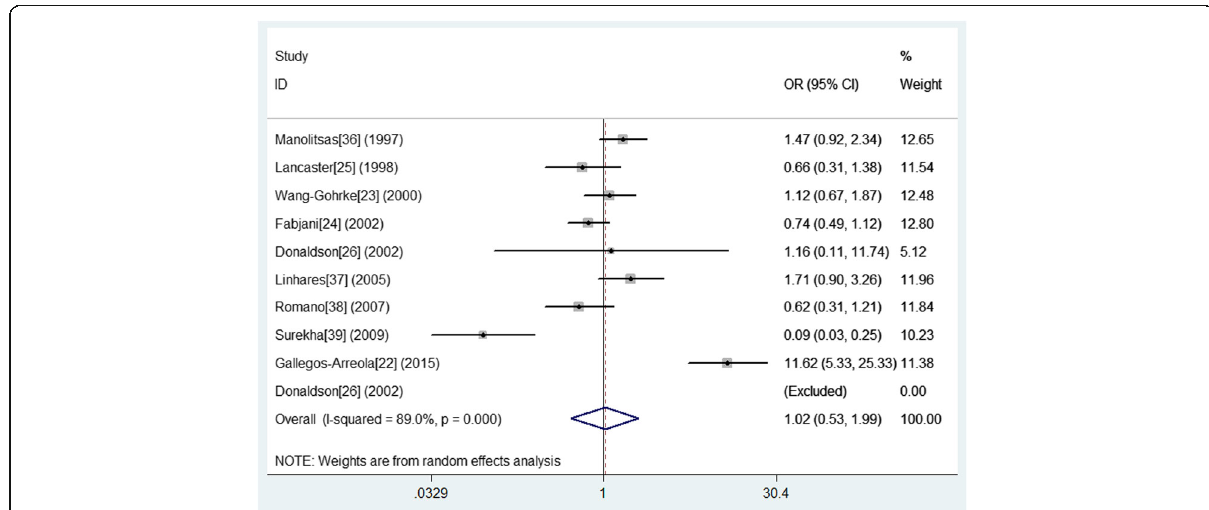
Fig. 2 Forest plot of the association between the Alu insertion in the PGR gene and breast cancer in a dominant model (T 1 T 2 + T 2 T 2 vs. T 2 T 2 )